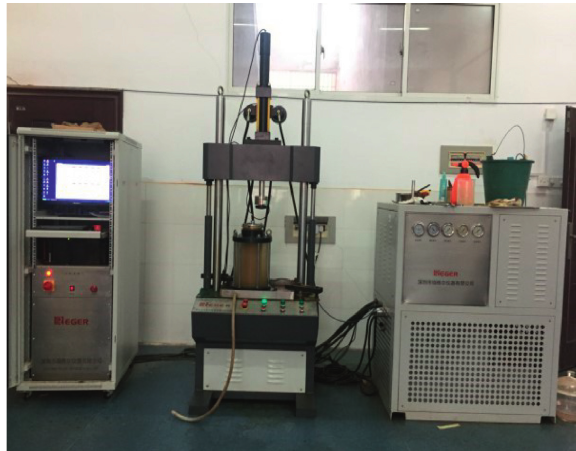
Figure 2: Triaxial compression servo testing